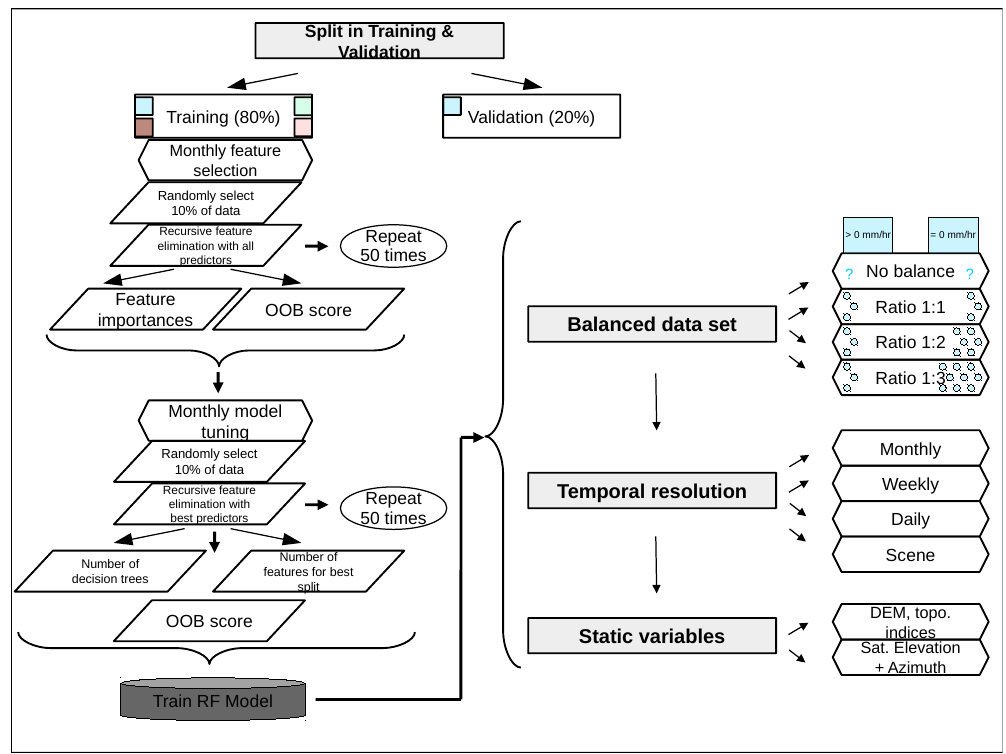
Figure 3. Workflow of the selection of the best model. See Section 2.4 for a detailed